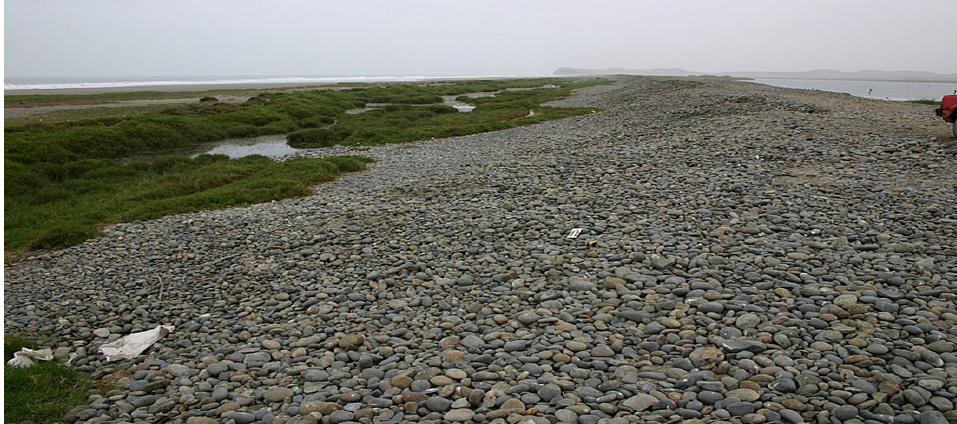
Figure 17. A linear beach ridge deposit along the Peru coastline resulting from an El Niño flood event. Note the marsh region behind the ridge resulting from the ridge blocking rainfall, river amuna discharge. The origin of such deposition events in history (Figure 6) is detailed in the next section.